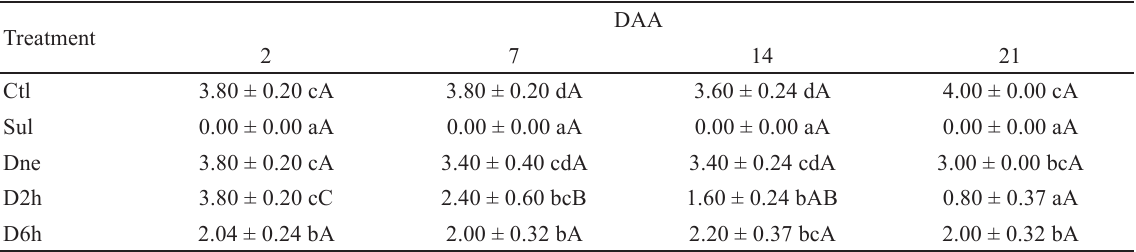
Table 1 . Grading scale (0 to 4) for the cutting of Acalypha sp. leaves by Atta sexdens rubropilosa workers after the treatment with baits at 2, 7, 14 and 21 DAA (days after application).